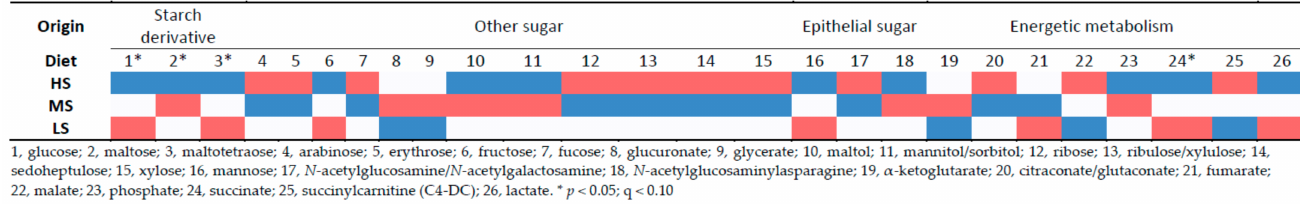
Figure 2. Heatmap of fecal saccharides metabolomics of dogs ( n = 24) fed diets produced at high, medium and low shear (HS, MS and LS, respectively). Specific analytes were numbered 1 to 26 and grouped as starch derivatives, other sugars, epithelial sugars and energetic metabolism. Estimate treatment means expressed in the Log 2 scale were color coded within each metabolite across diets on a color scale. Blue indicates a relative concentration lower than the other treatments, white indicates an intermediate relative concentration, and red indicates a higher relative concentration than the other